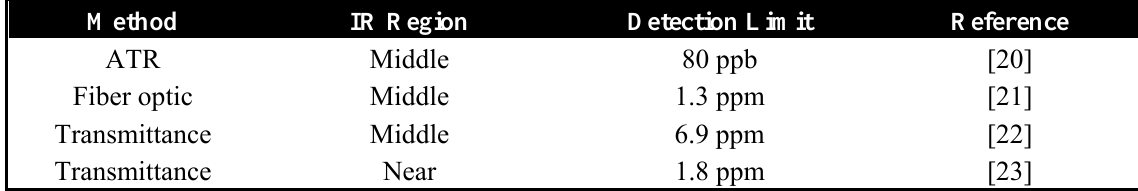
Table 1. Analytical properties of a variety of infrared spectroscopic sensors for toluene in water.